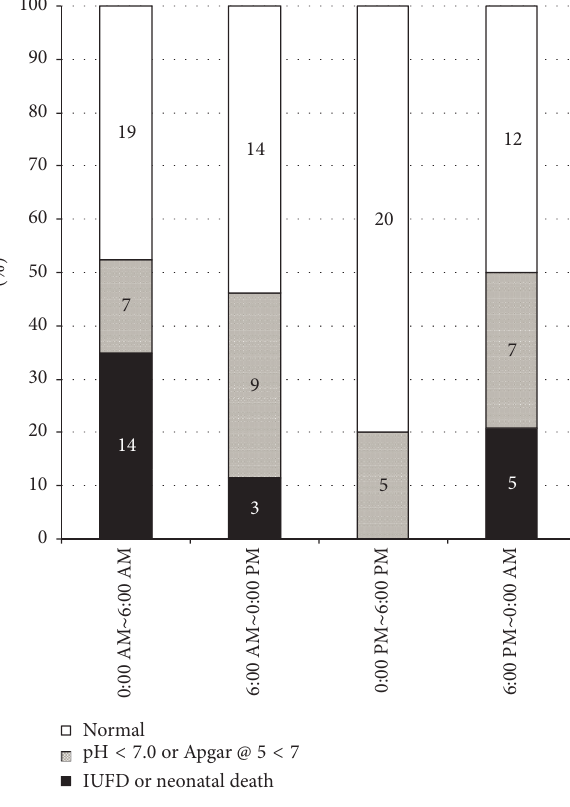
Figure 2: Circadian pattern of severe perinatal mortality. A case having IUFD, ND, low umbilical artery pH (UA pH < 7), or a low Apgar score at 5 minutes ( < 7) was regarded as having a severe perinatal outcome. Dark bar shows IUFD or ND. Striped bar represents low UA pH or a low Apgar score. White bar corresponds to the absence of severe perinatal mortality. Comparisons of the incidence of severe perinatal mortality among groups for the four 6-hour intervals in regard to placental abruption were made using 𝜒 2 tests followed by the Steel-Dwass test for multiple comparisons. A higher occurrence from 0:00 AM to 6:00 AM was detected when compared with 0:00 PM to 6:00 PM ( 𝑝 < 0.05 ). IUFD: intrauterine fetal death. ND: neonatal